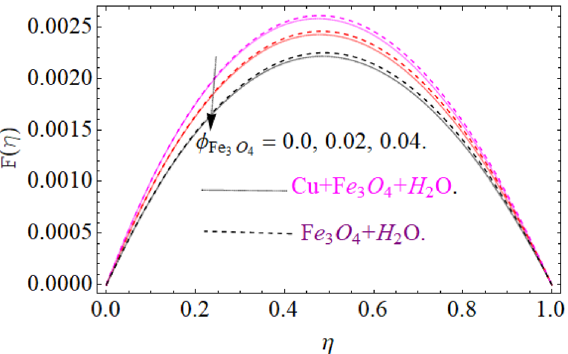
Figure 3. Impression of φ Fe 3 O 4 on F( η ), When M = 0.2, φ Cu = 0.02,Ec = 0.1, Pr = 6.2, Re ω = 0.3, Re � = 0.13